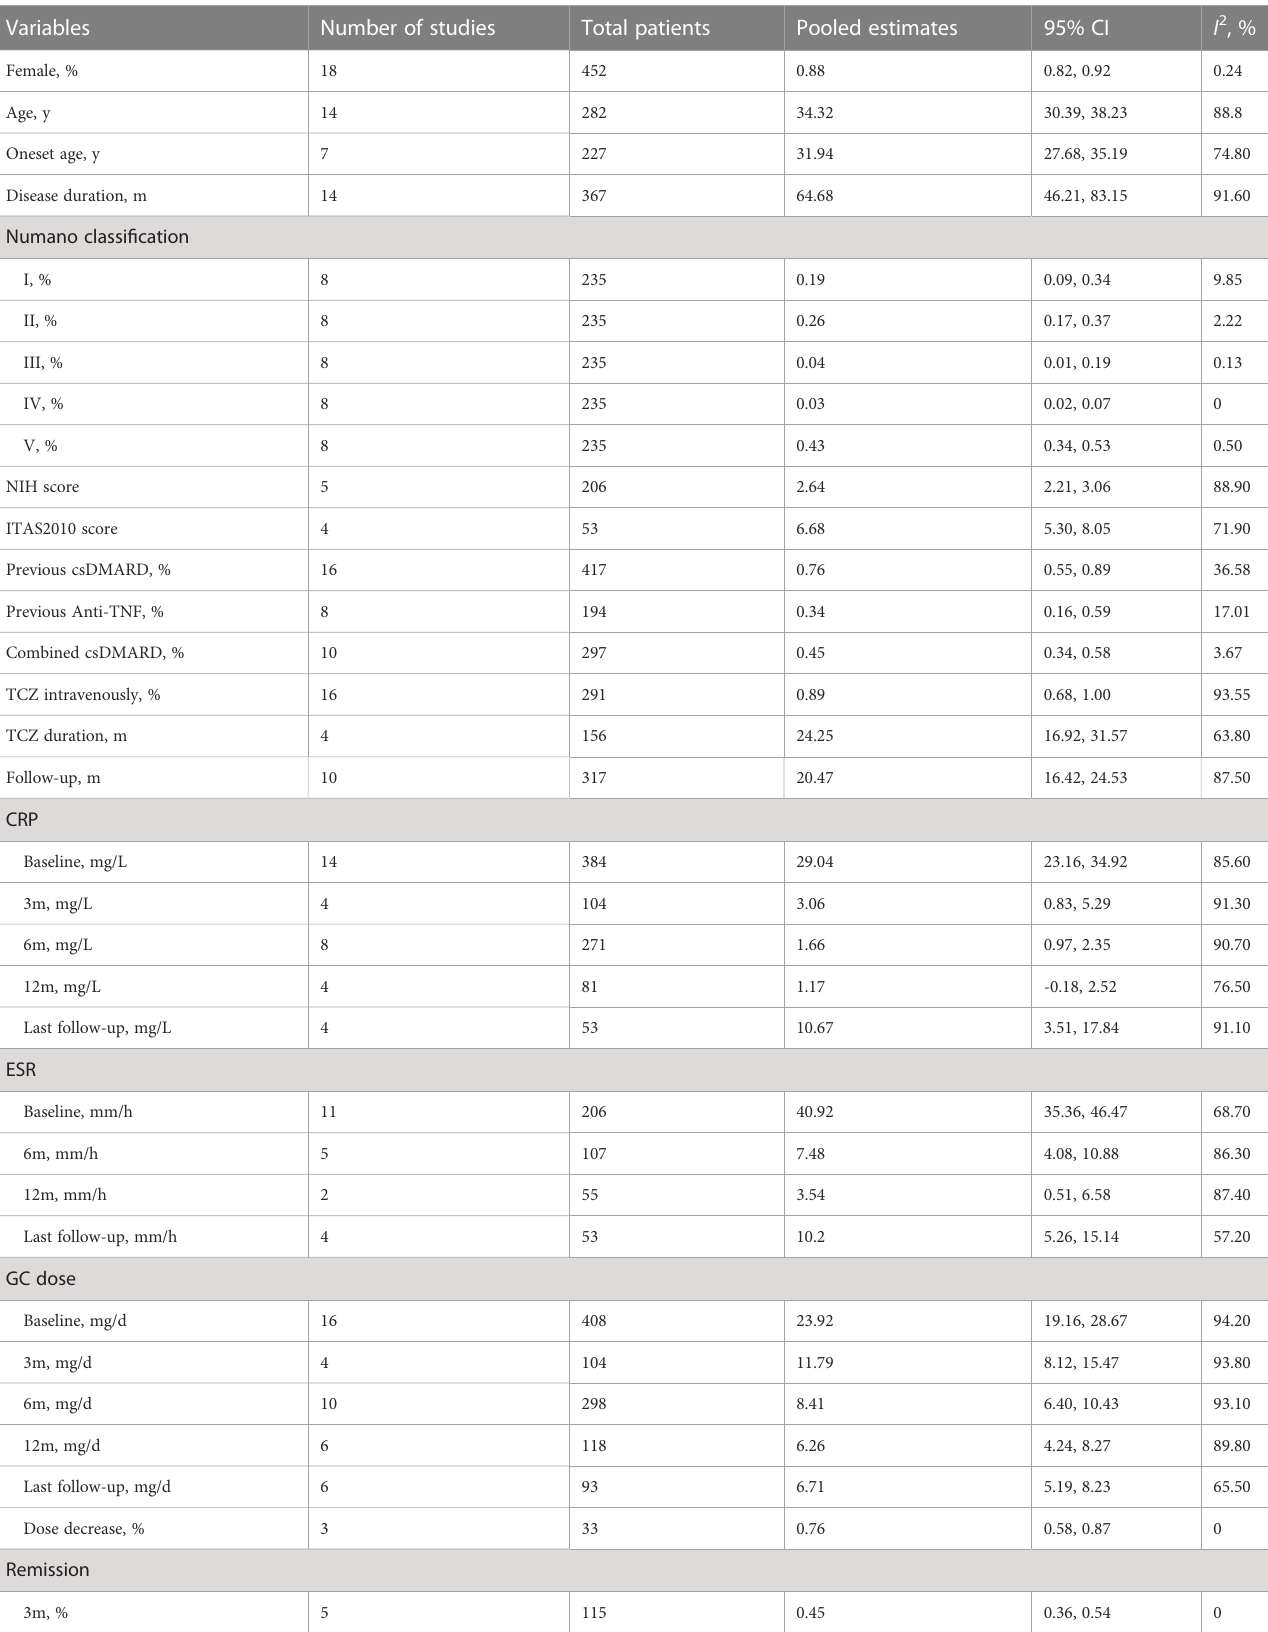
TABLE 2 Summary of patient-level information in the pooled results in this